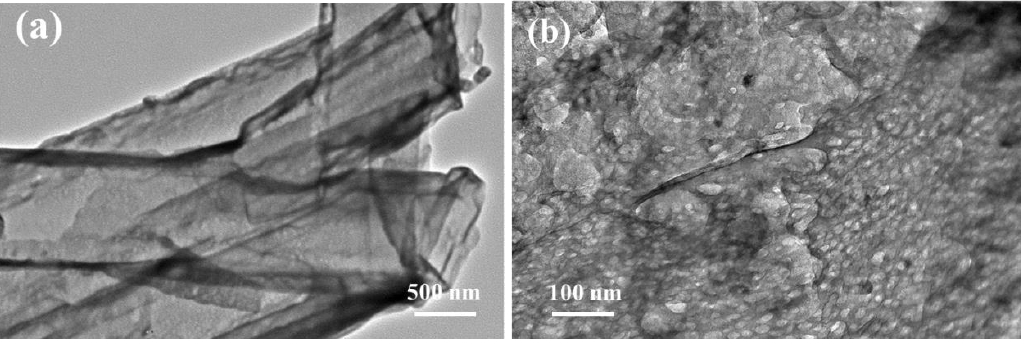
Figure 1. The SEM images of precursor ( a ), CNT ( b ), PCNT ( c ), NCNT ( d ), PNCNT ( e ) and the sur- face situation of PNCNT samples ( f ).